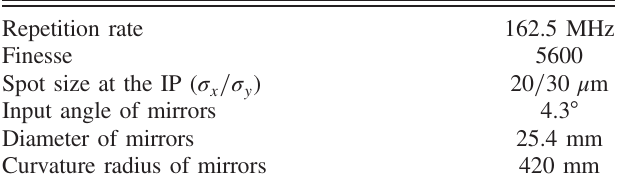
TABLE I. Design parameters of the optical cavity. Repetition rate